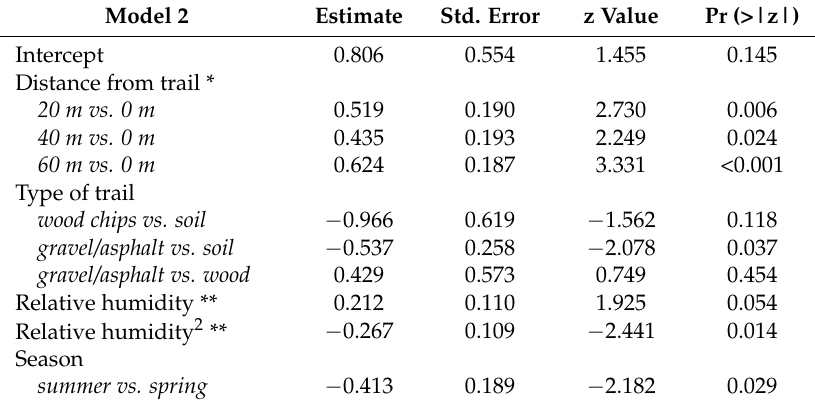
Table 4. Regression model for nymph counts per transect in 2013. We used a mixed Poisson regression model using park and plot identity as random